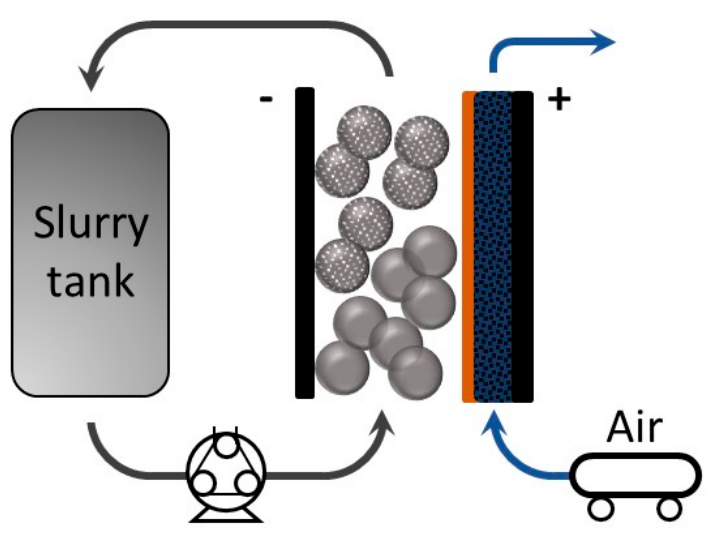
Figure 1. Schematic diagram of a zinc slurry air flow battery.